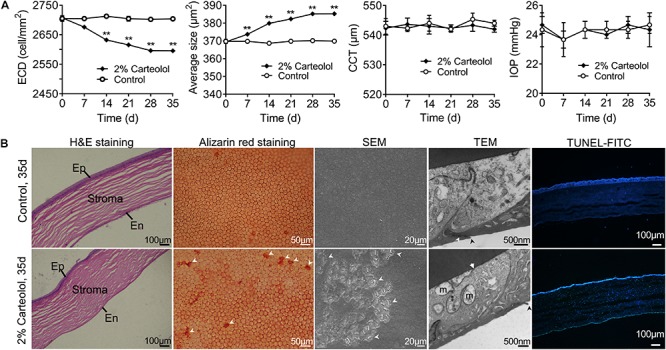
The effects of 2% carteolol for seven days on feline corneas in vivo. (A) Detection of endothelial cell density (ECD), average size, central corneal thickness (CCT), and intraocular pressure (IOP) after being treated with 2% carteolol. The ECD of 2% carteolol treated eyes decreased, and the average size increased as compared with control eyes (P < 0.01). The results showed that CCT and IOP had no obvious differences from those of control eyes (P > 0.05). The time-dependent recovery of ECD, average size, CCT and IOP of carteolol eyes, and control eyes are shown, respectively (n = 3). **P < 0.01 vs control. (B) H&E staining of paraffin-embedded sections showed that the feline cell endothelium was shed after being treated with 2% carteolol, Ep: epithelium, En: endothelium. Alizarin red staining revealed that 2% carteolol-treated feline endothelial cells were larger than those of control eyes. The cell structure was disordered and the microvilli were decreased on the cell surface as compared with normal eyes by SEM observation. Moreover, the intercellular tight junctions of corneal endothelial cells and the mitochondria were swollen as seen by TEM observations, m: swollen mitochondrion, arrow: impaired cell junction; Apoptosis cells was examined by terminal deoxynucleotidyl transferase-mediated dUTP nick-end labeling (TUNEL) staining with fluorescein isothiocyanate (FITC) fluorescent dye, with nuclei counterstained with 4′,6-diamidino-2-phenylindole (DAPI). Images represent n = 3.